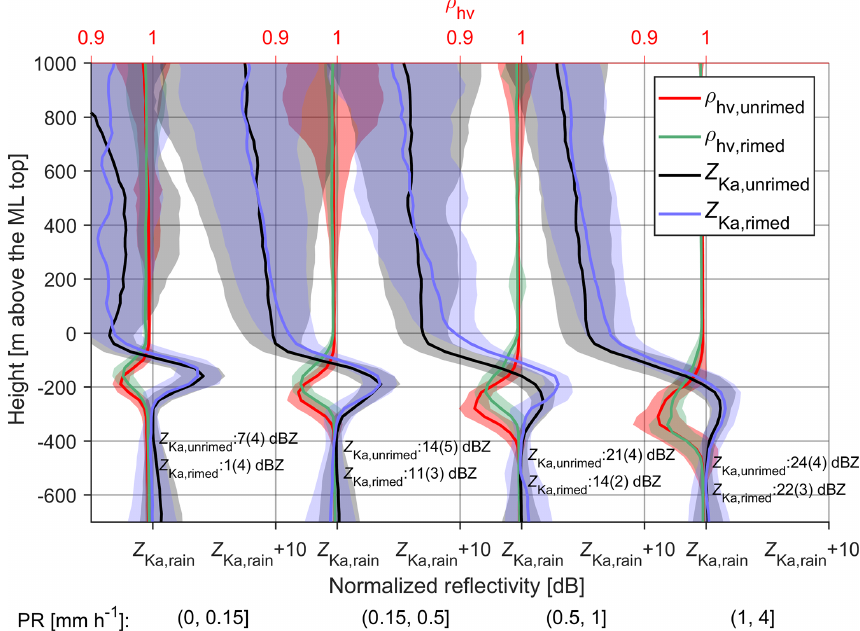
Figure 8. Same as Fig. 5 but for Ka-band radar. Note that the calibration is made by matching the Ka-band reflectivity with X-band at precipitation top, while the attenuation in the profile is not accounted for. To be in line with Fig. 5, ρ hv observed by X-SACR is presented instead of the LDR measured by Ka-SACR.